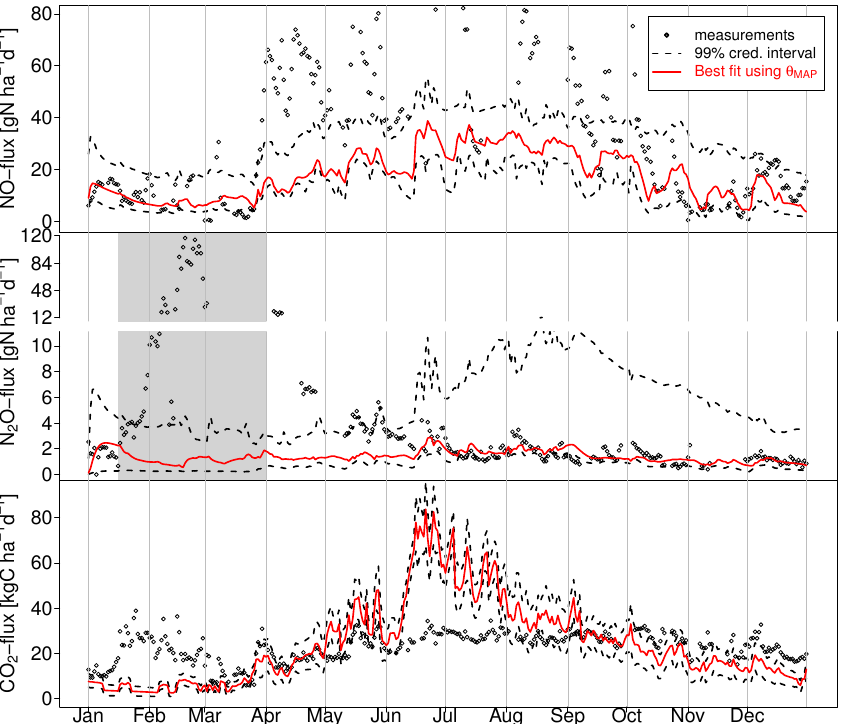
Fig. 6. Simulated fluxes (validation set) versus measurements of NO, N 2 O and CO 2 fluxes at the spruce site of the H¨oglwald forest in the year 2006. The grey box highlights pulse emissions of N 2 O during soil freeze-thaw